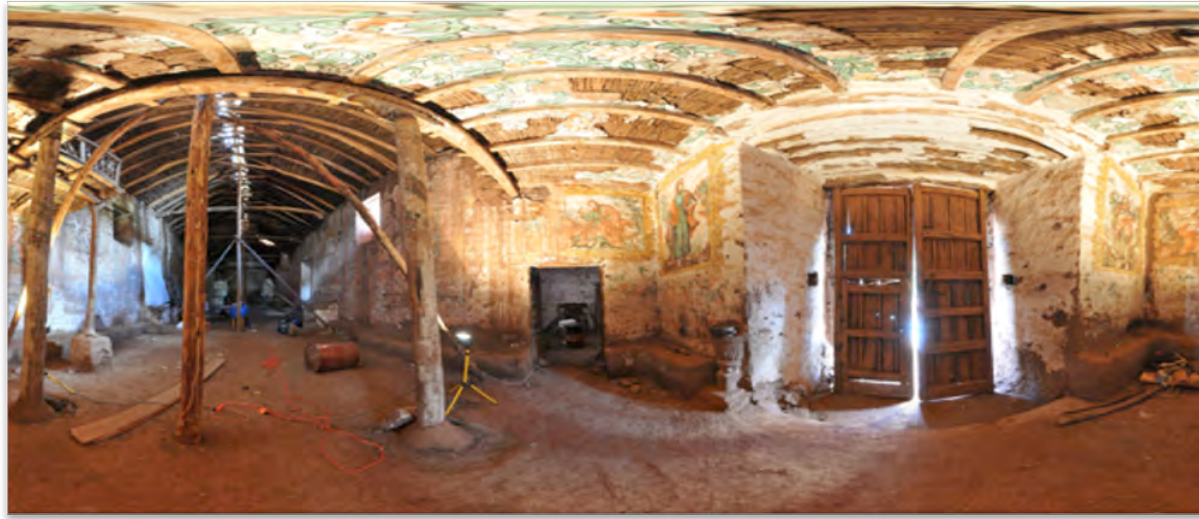
Figure 1. Panoramic spherical image of the interior of Kuño Tambo church,